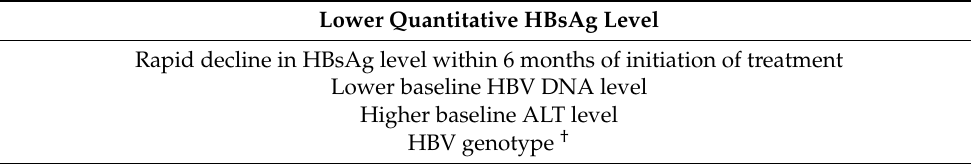
Table 2. Factors associated with HBsAg loss on